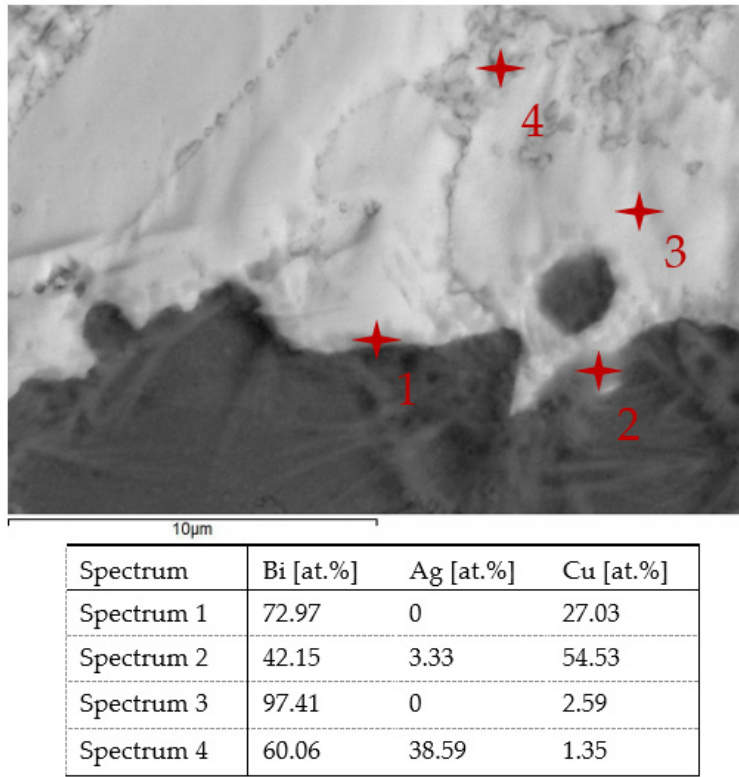
Figure 18. Point EDX analysis of boundary in Cu/Bi11Ag1.5Ti joint.